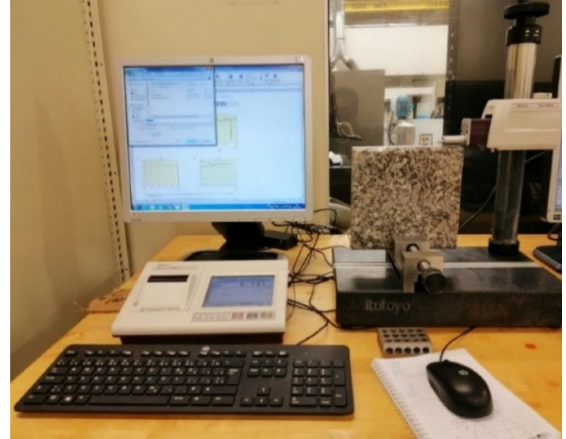
Figure 6. Mitutoyo Surftest SJ-410